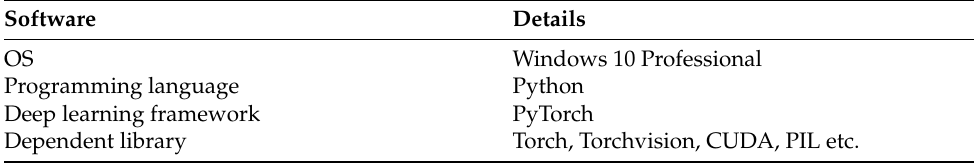
Table 1. Software environment configurations used in this paper.